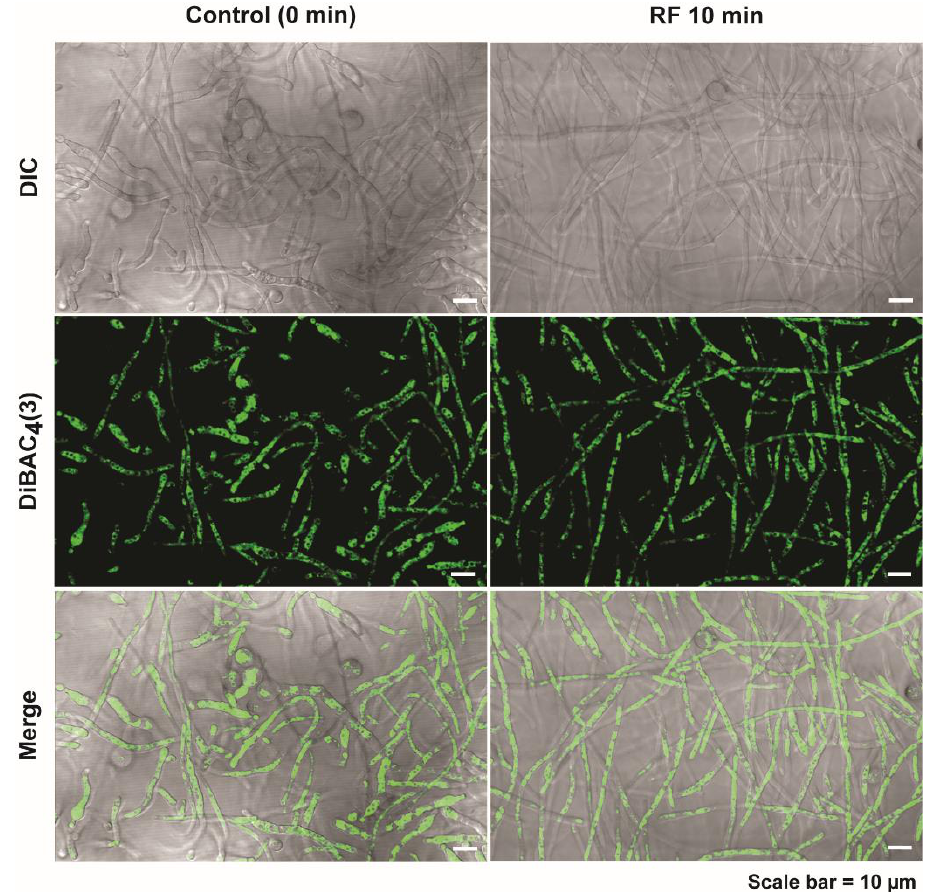
Figure 6. Membrane potential assay using a fluorescent indicator, DiBAC4(3), in fungal hyphae at 16 h after fungal spores were unexposed (control) and exposed to RF-EMF (2 GHz, 0.01 W) for 10 min.